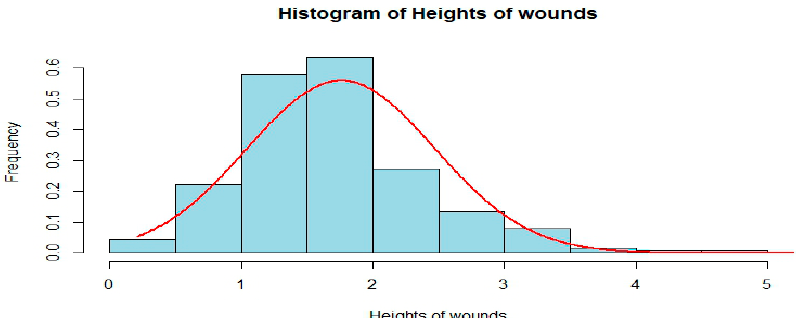
Figure 6. Height to wound distribution frequency showing that 95% of the trees had wounds located lower than 3.2 m ( p -value = 3.154e - 15 ; field measurements).